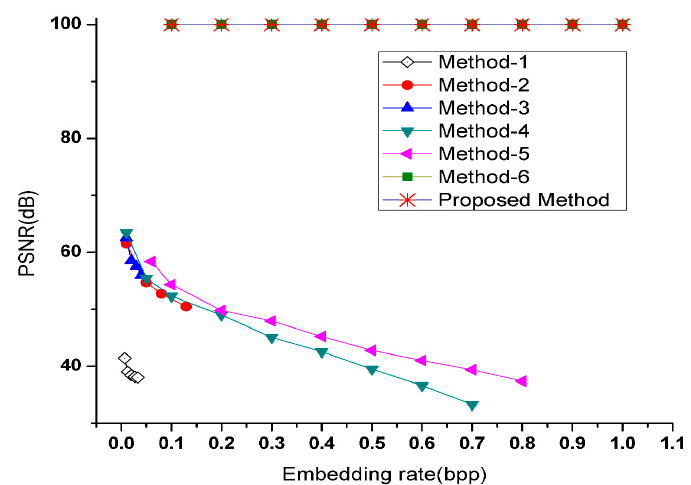
Figure 10. Performance comparison on the test image Lena for compared schemes Method-1 [9],